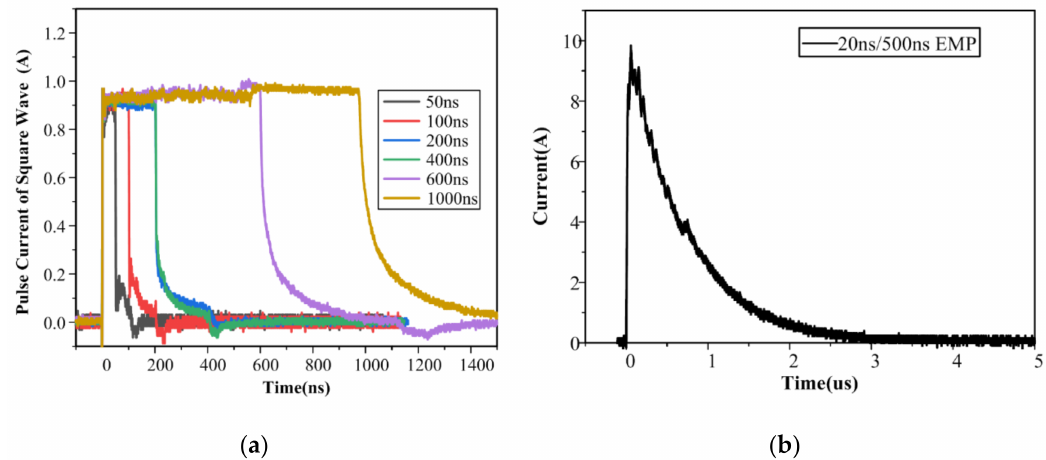
Figure 5. Standard wave of PCI generator output: ( a ) square waves; ( b ) double exponential wave.